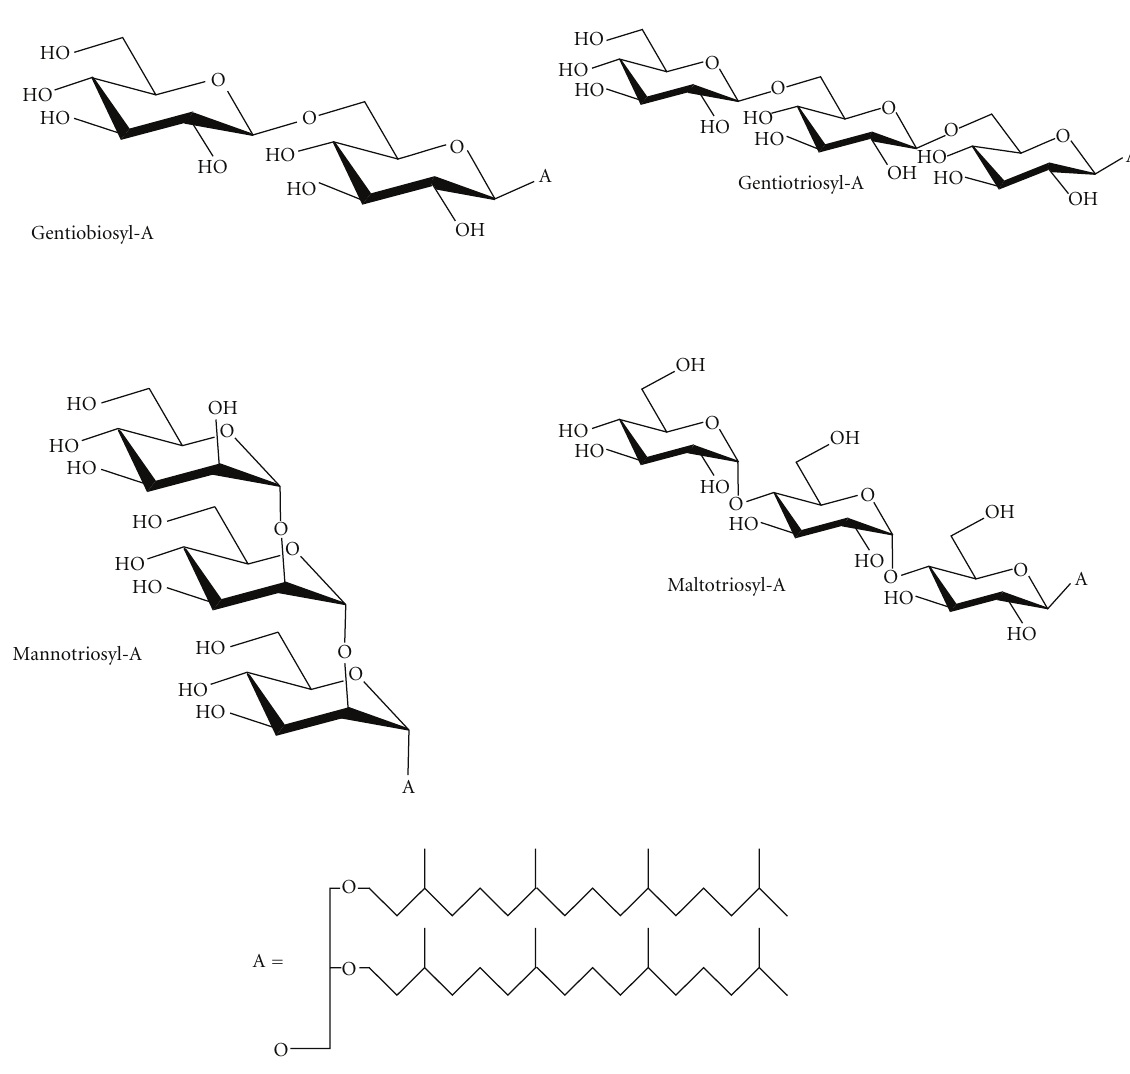
Figure 1: Semisynthetic glycoarchaeol structures showing head group details. “A” is the archaeol lipid precursor used for synthe- sis. gentiobiosyl-A ( β -Glc p -(1 → 6)- β -Glc p -(1 → O)-archaeol); Gentiotriosyl-A ( β -Glc p -(1 → 6)- β -Glc p -(1 → 6)- β -Glc p -(1 → O)-archaeol); mannotriosyl-A ( α -Man p -(1 → 2)- α -Man p -(1 → 2)- α -Man p -(1 → O)-archaeol); maltotriosyl-A ( α -Glc p -(1 → 4)- α -Glc p -(1 → 4)- β -Glc p -(1 →